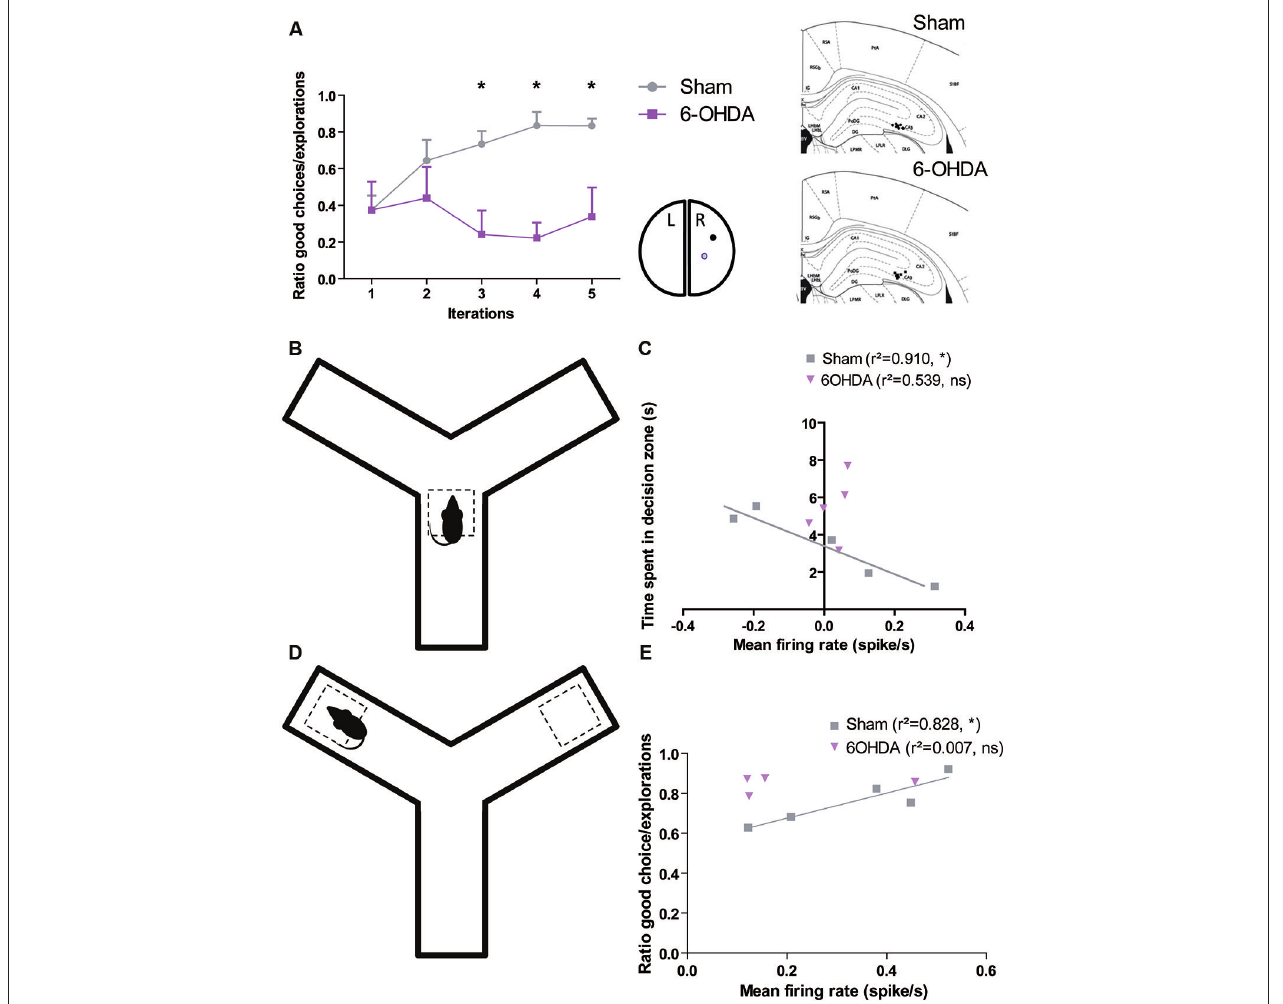
exploration. We correlated the behavior in the maze with population responses in the right CA3 (A, right). The time spent by the animal in the decision zone (B) is correlated with the population firing rate of CA3 neurons of Sham, but not 6-OHDA rats (C) . The ratio of good choice/total number of exploration is correlated with the population firing rate of CA3 neurons of Sham, but not 6-OHDA rats (E) when the animal is in the reward location (D)